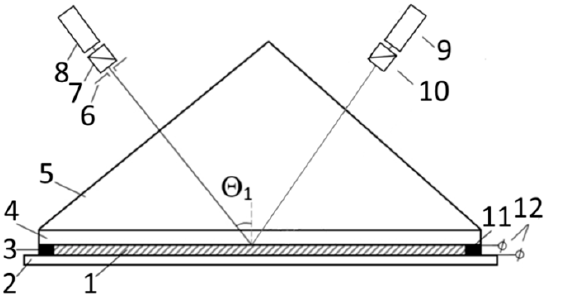
Figure 2. Experimental setup for determining the frequency of fluctuations in the concentration of particles in a liquid membrane. 1—ferrocolloid; 2—a plate of foil getinax; 3 and 11—insulating gaskets; 4—ITO-covered glass; 5—rectangular isosceles prism; 6—diaphragm; 7 and 10—Polaroid camera; 8—photodiode; 9—laser; 12—electrodes.